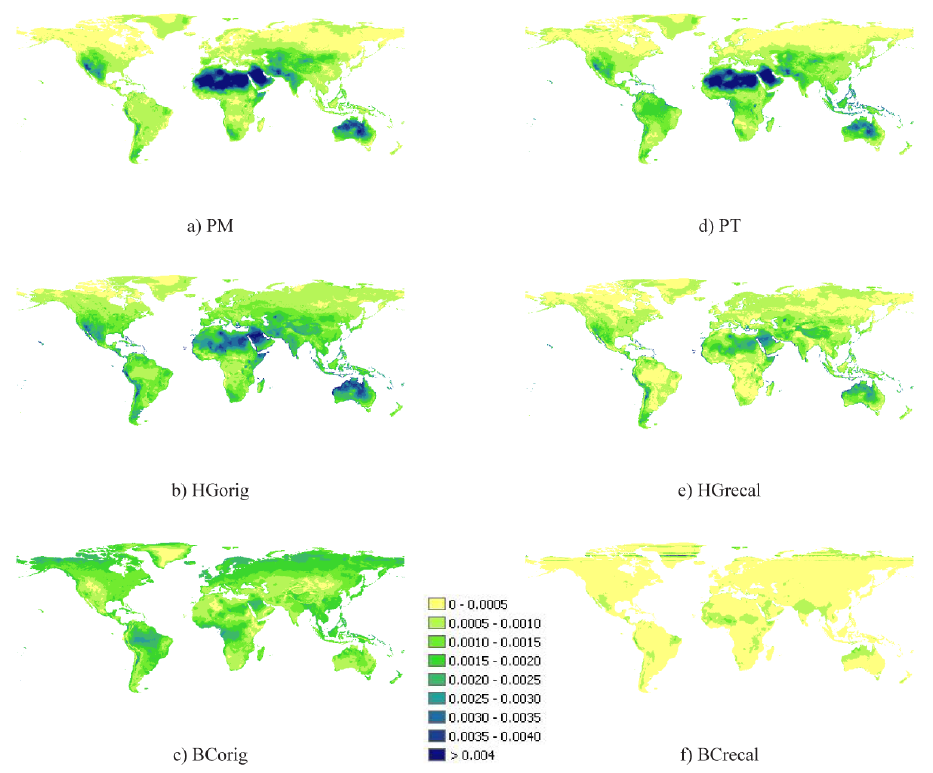
Fig. 6. Global maps with cell specific root mean square differences (RMSD) calculated between the CFSR derived monthly PET time series and the monthly PET timeseries derived from the CRU dataset with the Penman-Monteith equation. In the left column from top to bottom; Penman-Monteith (PM), the original Hargreaves method (HGorig) and Blaney-Criddle equation (BCorig) and in the right column; Priestley-Taylor (PT), Hargreaves with increased multiplication factor (HGrecal) and the re-calibrated Blaney-Criddle equation (BCrecal) are